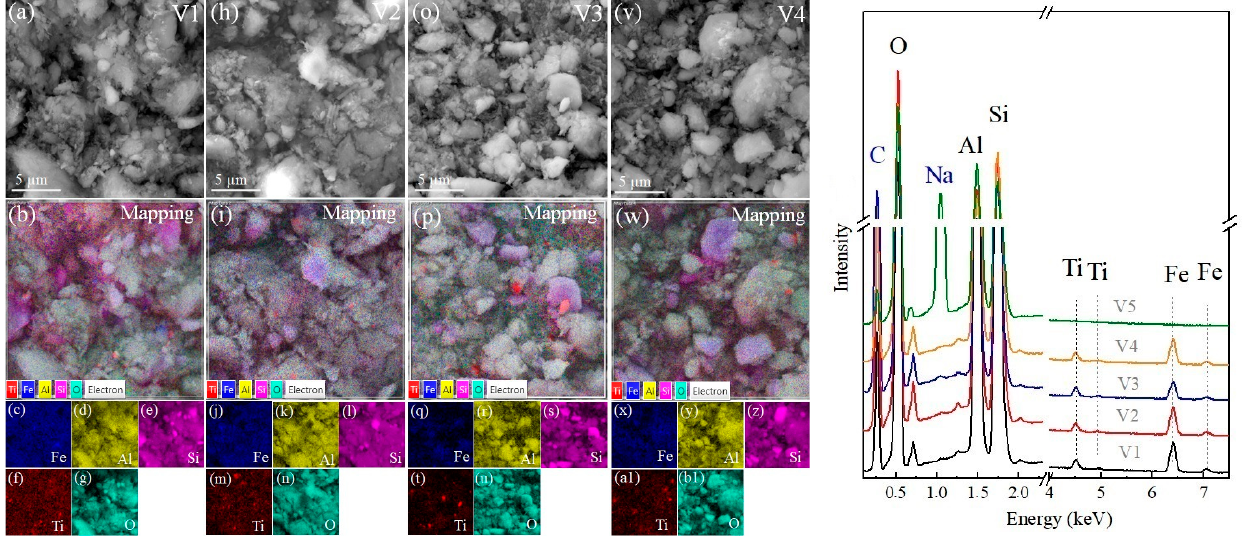
Figure 7. ( a ) SEM image, ( b ) EDS mapping region and ( c – e ) elemental (Al, Si, and O) analysis for zeolite 5A material.